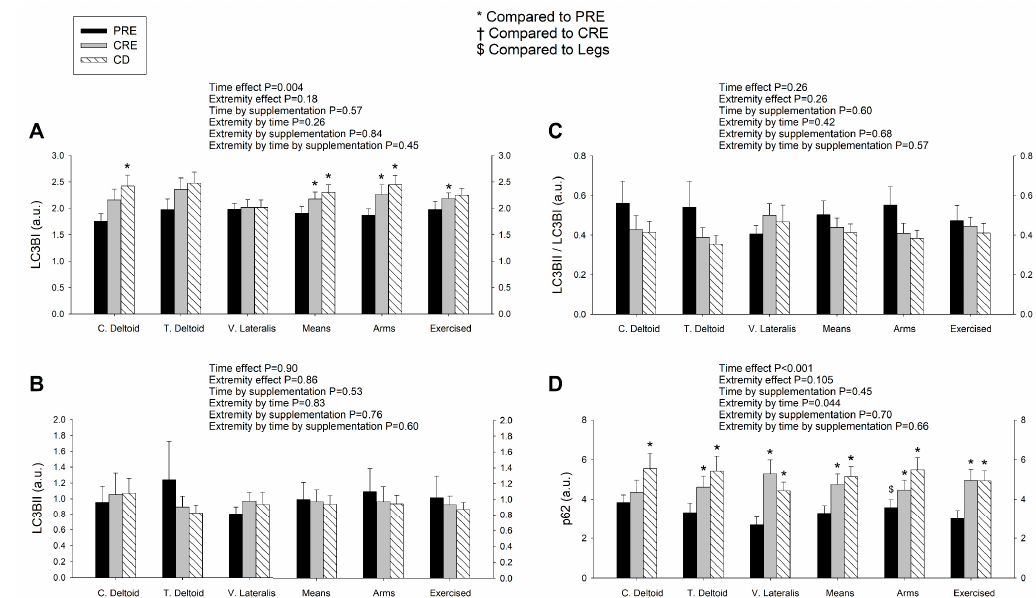
Figure 4. LC3BI expression in skeletal muscle increases with a severe energy deficit, but LC3BII and the LC3BII/LCBI ratio remain unaltered, while the augmented levels of p62/SQSTM1 are amplified by exercise in a dose-dependent fashion. Protein expression levels of of LC3BI ( A ), LC3BII ( B ), ratio LC3BII / LCBI ( C ), and p62 / SQSTM1 ( D ) in skeletal muscle following the three experimental LC3BII/LCBI ( C ), and p62/SQSTM1 ( D ) in skeletal muscle following the three experimental phases.